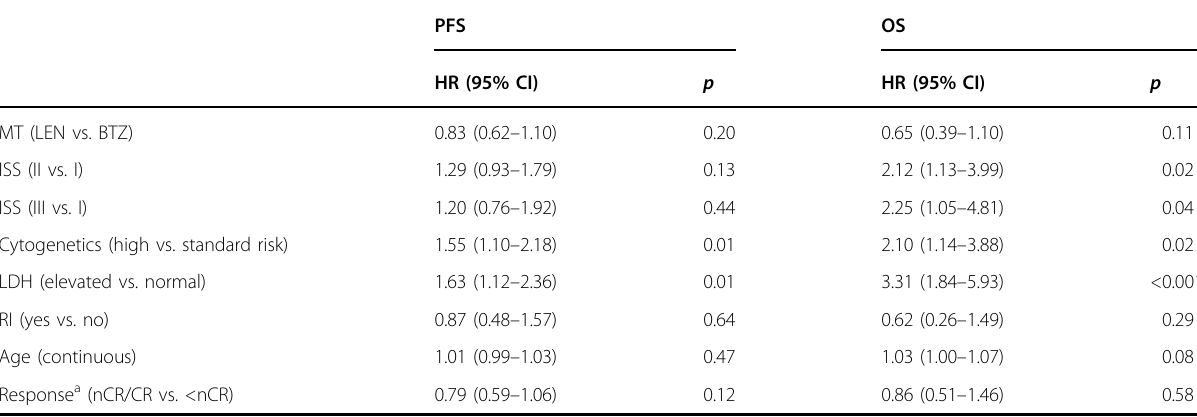
Table 3 Multivariate analysis on PFS and